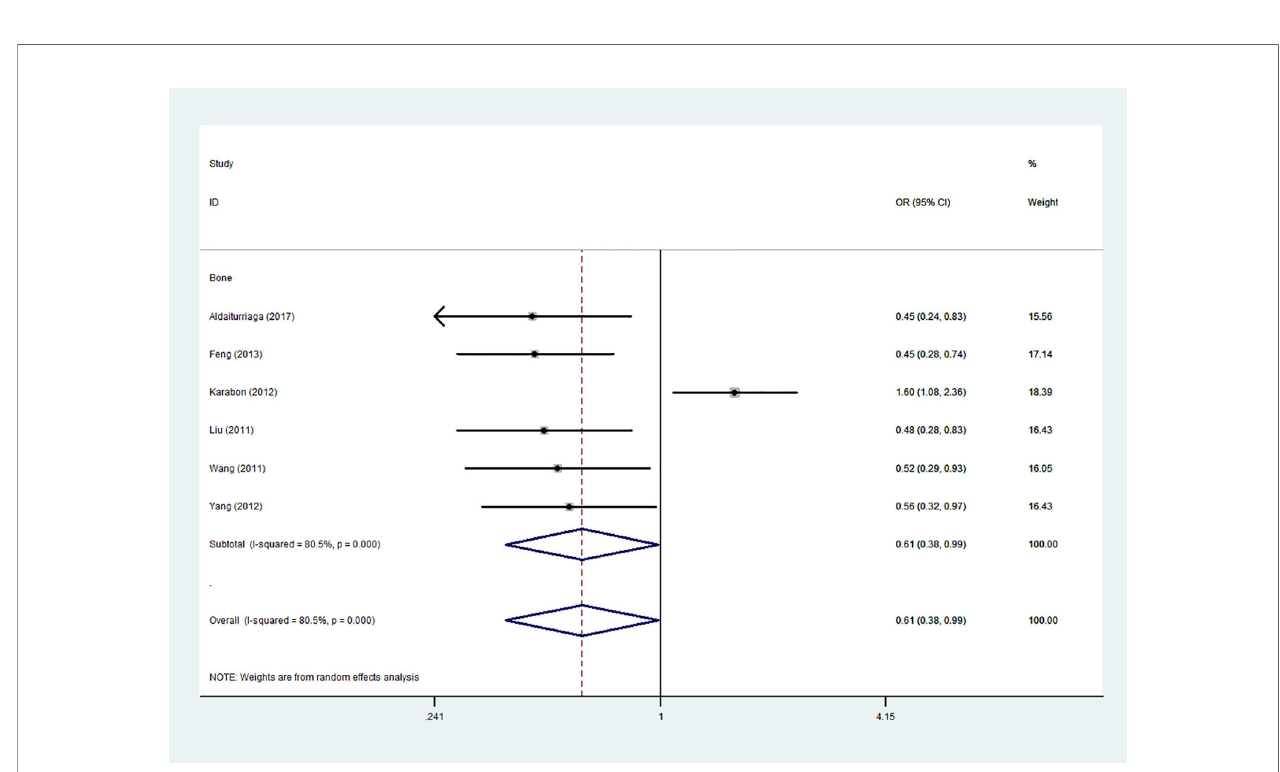
FIGURE 7 | Forest plot of the association between the CTLA-4 gene rs231775 polymorphism and bone cancer risk (G-allele vs. A-allele).